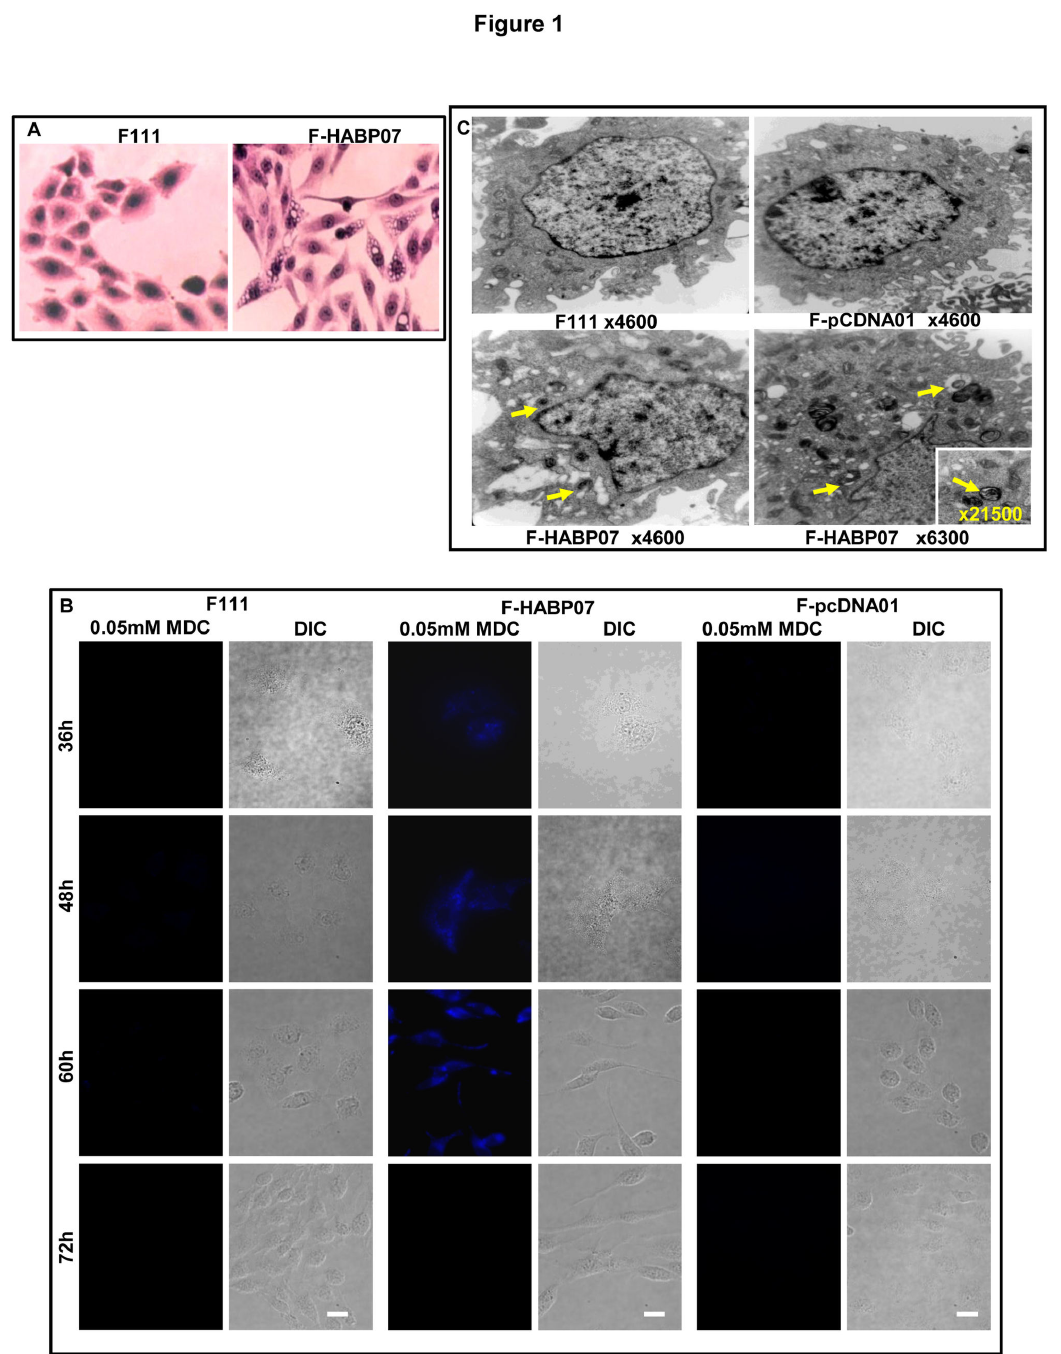
Figure 1. Characterization of vacuolation in HABP1 overexpressing fibroblast (F-HABP07). [A] Altered morphological appearance -- Visualization of numerous vacuoles in F-HABP07 cells at 48 h upon Haematoxylin-Eosin staining, under light microscope (40X Magnification). [B] Identification of autophagic vacuoles using MDC staining -- F111, F-HABP07 and F- pCDNA01 cells grown for different time points were stained with the auto-fluorescent compound, MDC (0.05mM) which specifically stains autophagic vacuoles, confirms autophagic vacuolation at 36, 48 and 60 h of growth in F-HABP07 cells only. Scale=10µ. [C] Transmission Electron Microscopy -- Ultrastructure confirms autophagic vacuole (yellow arrow) generation in F-HABP07 cells with respect to parental control F111 and vector control F-pCDNA01. Magnification (x) of ultramicrograph has been mentioned in each corresponding figure. doi: 10.1371/journal.pone.0078131.g001 PLOS ONE |